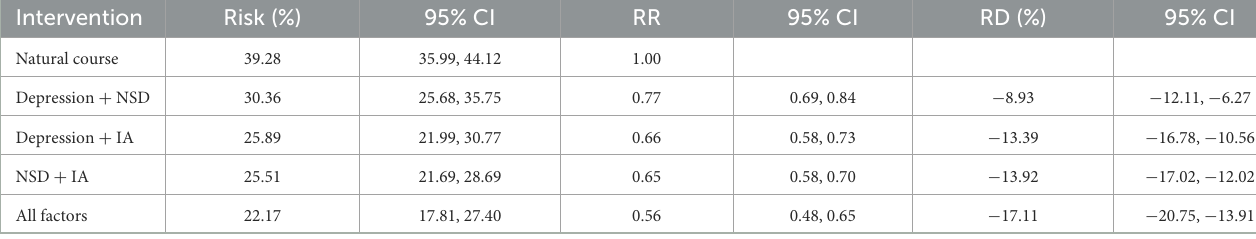
TABLE 4 Cognitive impairment risks at 7-year follow-up under natural course and single hypothetical interventions in subgroups stratified by gender. Intervention Risk (95% CI)